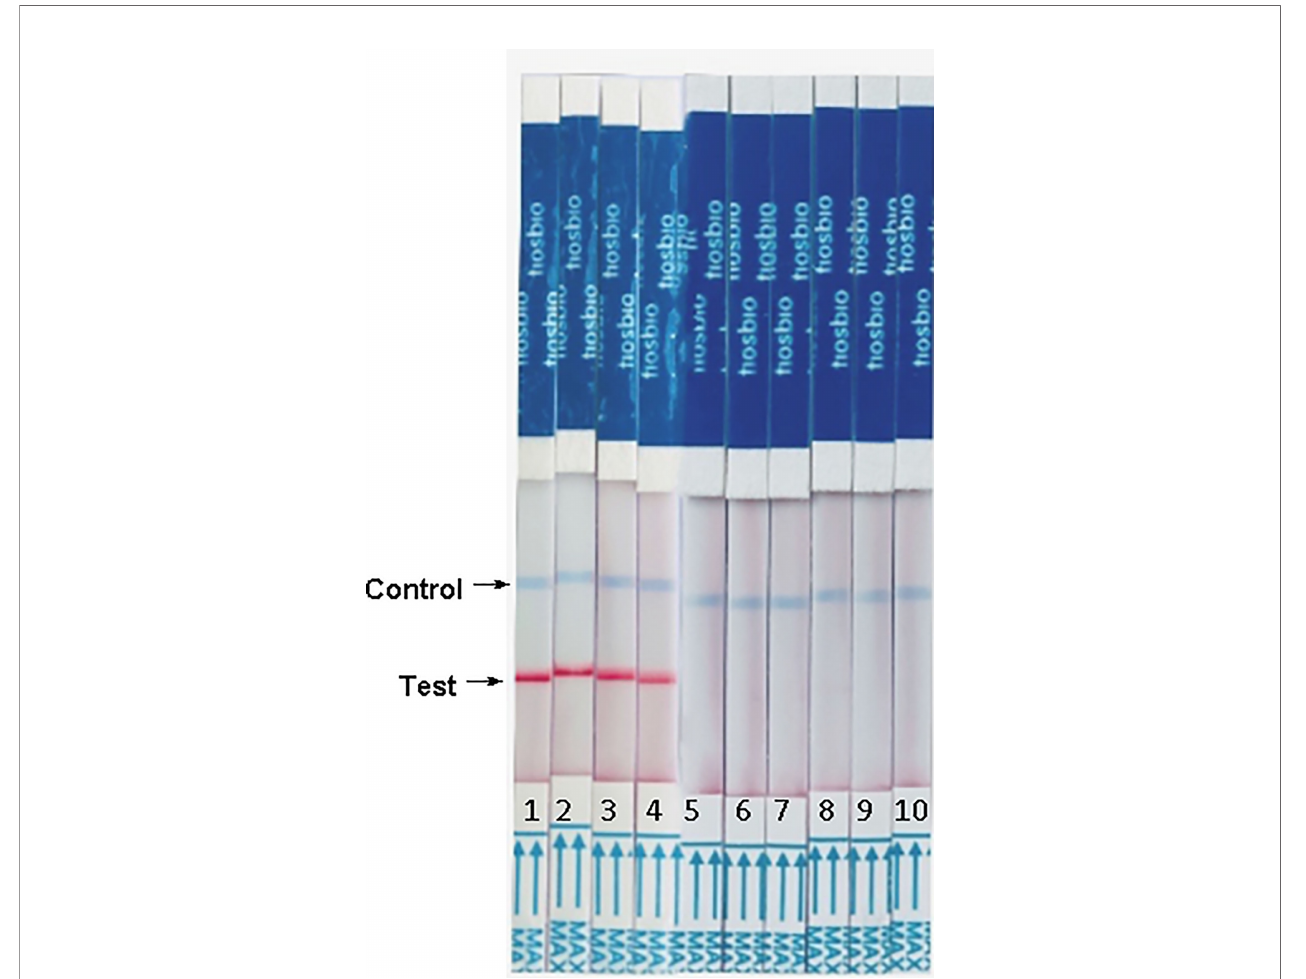
FIGURE 4 | Analytical speci fi city of reverse transcription RAA-LFD assay. From left to right, the test samples are 1- P. vivax , 2- P. malariae , 3- P. falciparum , 4- P. ovale , 5- Leishiamnia donovani , 6- Leishiamnia infatum , 7- Toxoplasm gondii , 8- Babesia microti , 9- Anaplasma phagocytophilum and 10-negative control, H 2 O.